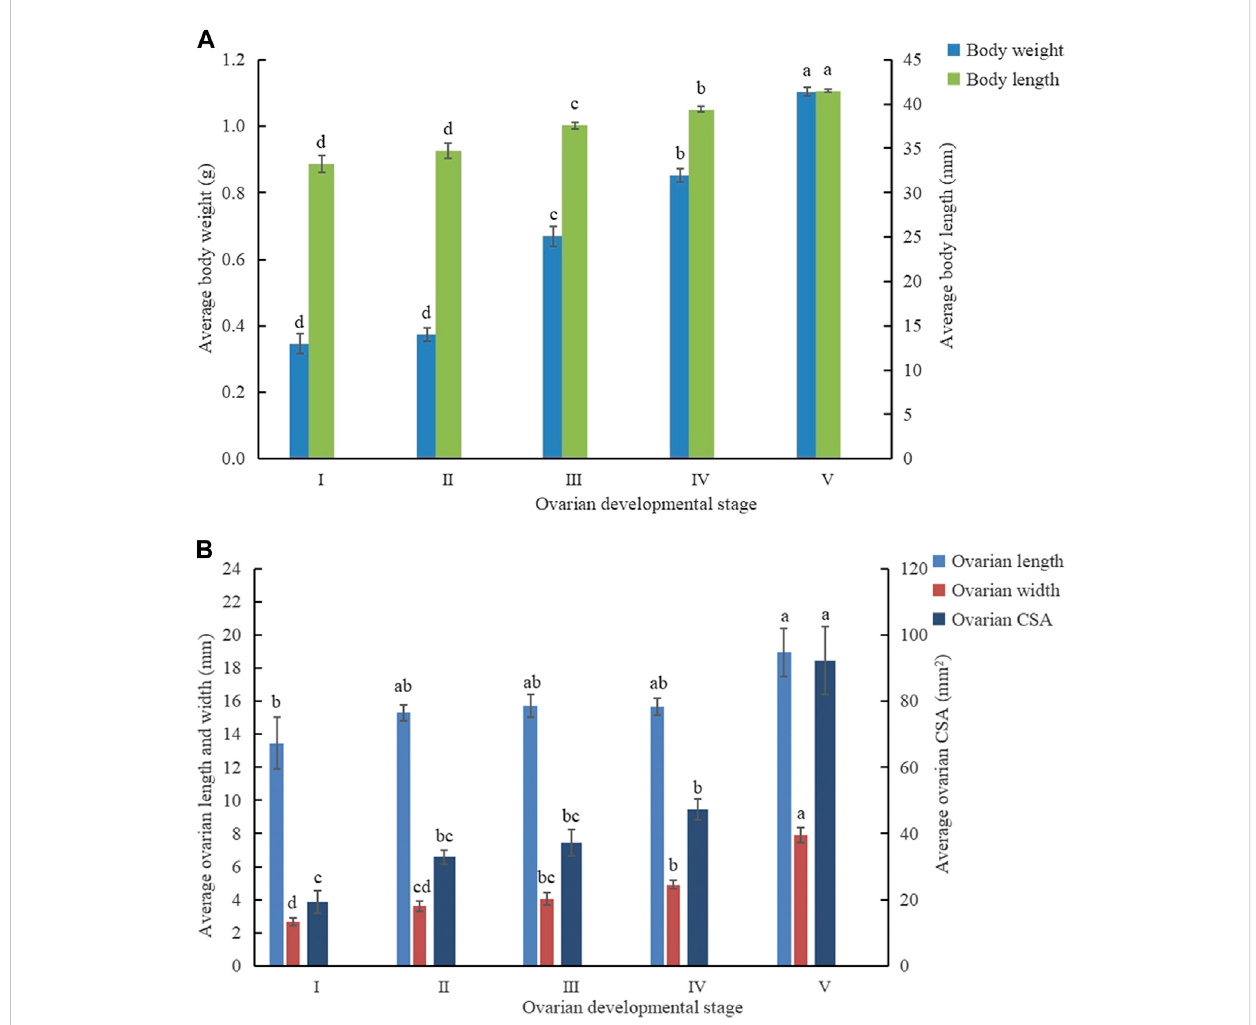
FIGURE 4 Mean value (±SE) at different ovarian developmental stages of (A) phenotypictraits and (B) ovariandevelopmental parameters. CSA, cross-sectional area.